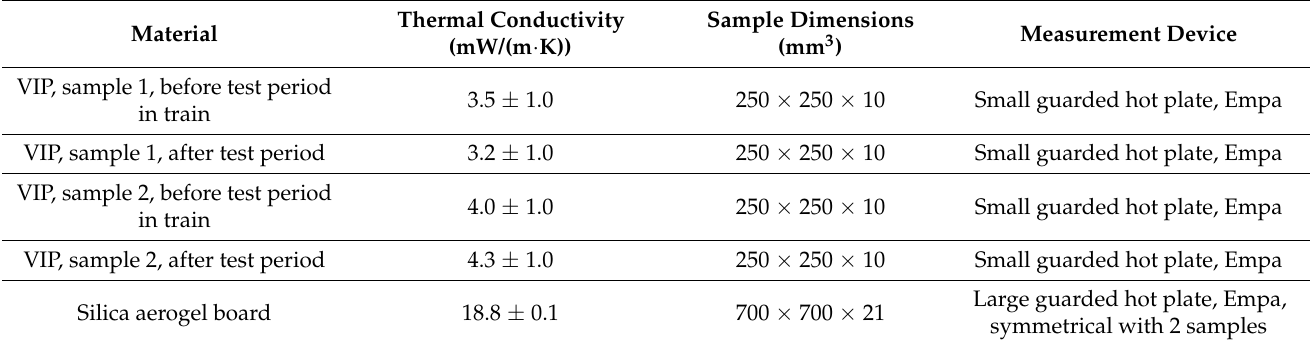
Table 2. Results of the thermal conductivity measurements conducted at